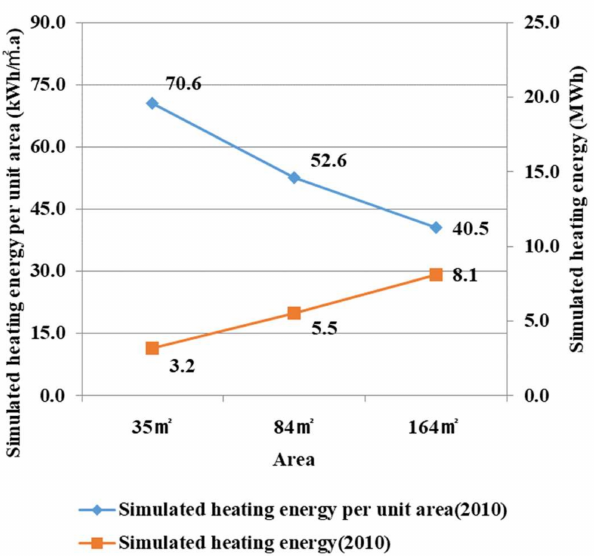
Figure 12. Simulated heating energy consumption and heating load per unit area (EnergyPlus).